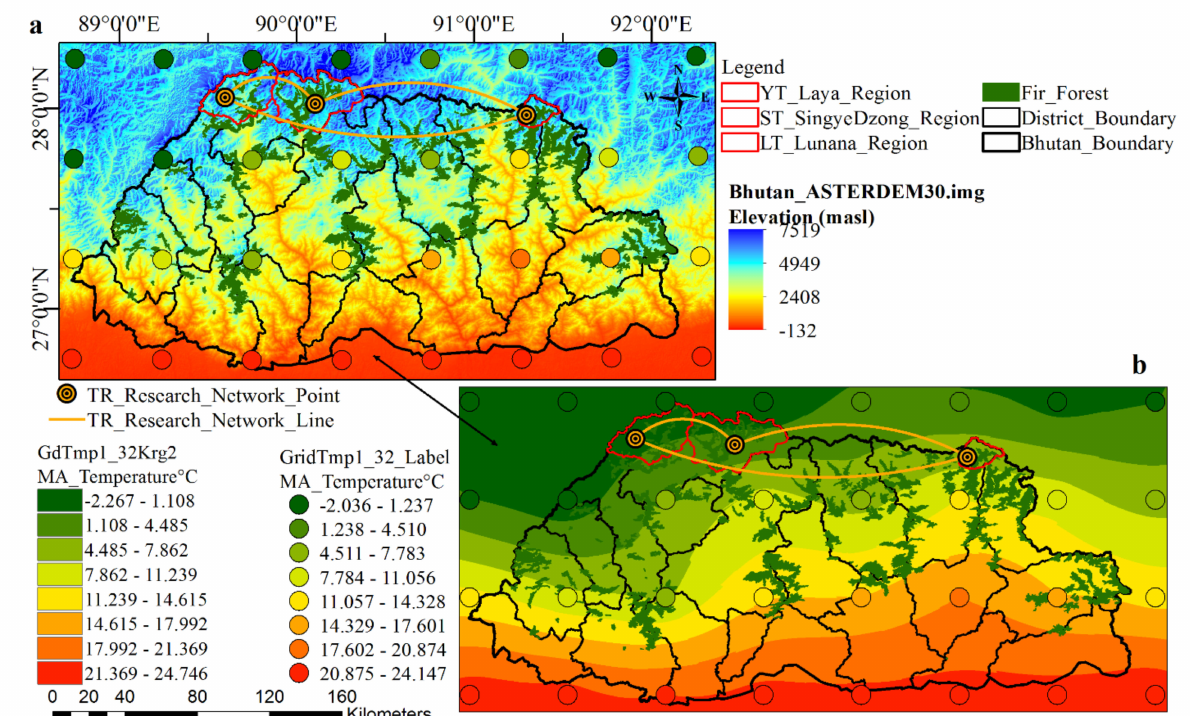
Figure 10. Interpolation and distribution of temperature, elevation (DEM), Fir forests and treeline ecotone regions in Bhutan. ( Upper panel ) ( a ) covers digital elevation model displaying spatial distri- bution of elevation gradients and ( lower panel ) ( b ) portrays interpolated thirty-two gridded CRU mean annual temperature (mean of 1970-2016) over Bhutan and neighbour regions. Biogeographic regions (Lunana, Laya and Singye—pink boundary polygons) and three treeline ecotone sites (golden concentric circles connected by thick polygon lines) are shown in both panels. Interpolated thirty- two gridded CRU station mean temperatures (1970-2016) within circles (Bhutan (Label-MA-TEM) in different coloured are overlaid to depict as reference over ( a ) elevation zones and ( b ) gridded temperatures. Fir forest areas are marked by dark green in both